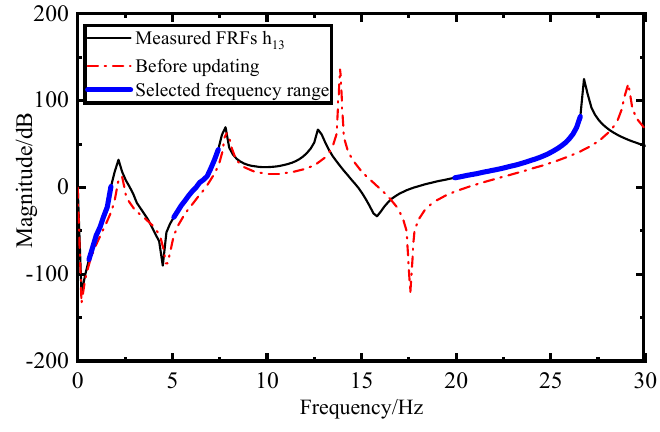
Figure 15. Selected frequency range.